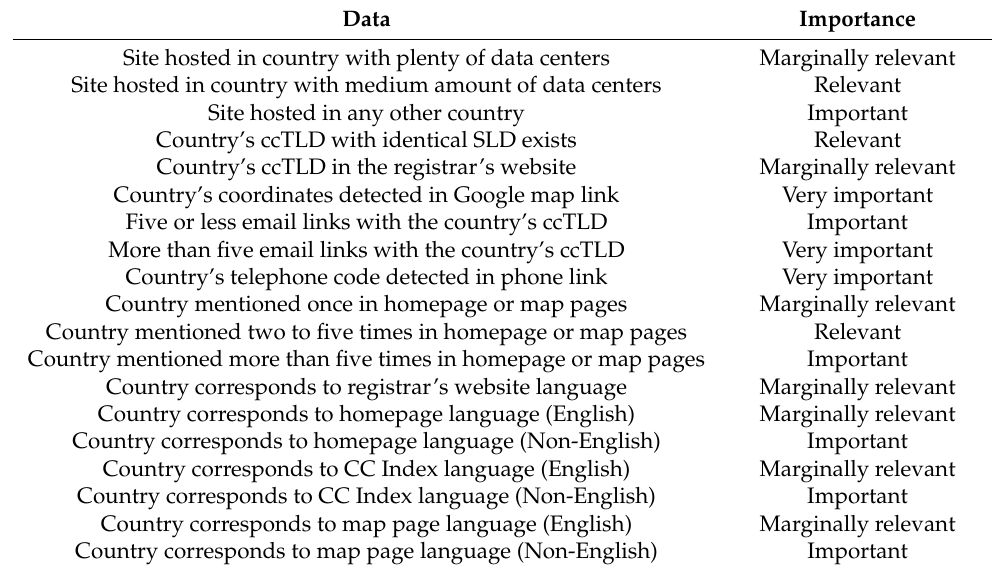
Table 2. Importance of various examined